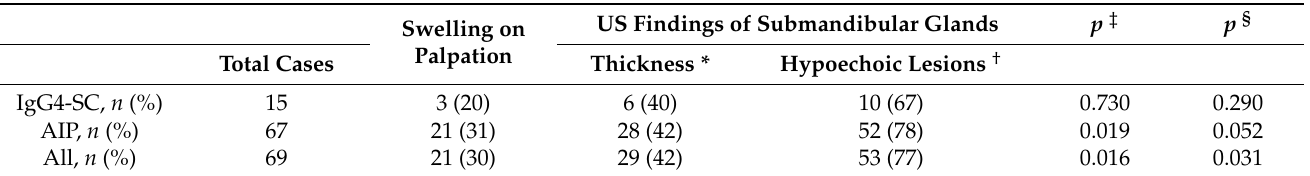
Table 3. Prevalence of sialadenitis diagnosed based on the presence of swelling or hypoechoic lesions in patients with AIP and IgG4-SC. US Findings of Submandibular Swelling on Palpation